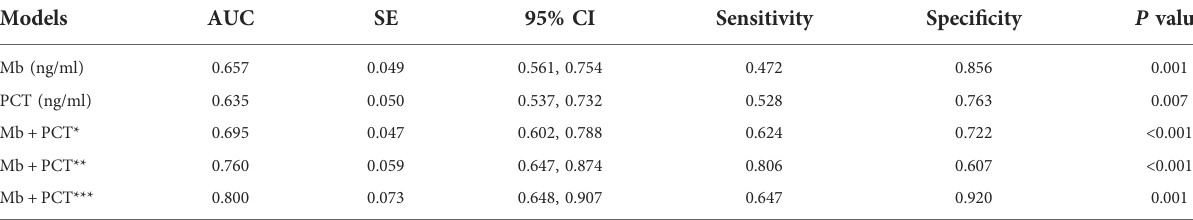
TABLE 4 Prediction of different models for EAD.